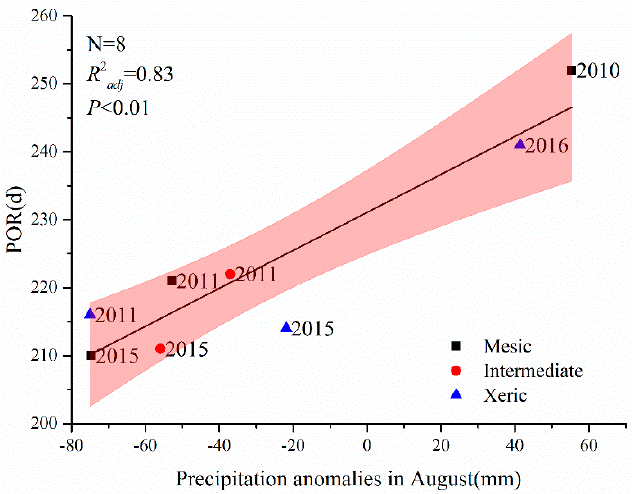
Figure A5. Impact of precipitation in August on POR (peak of recovery) after short-term summer drought by site. Pink shaded area represents 95% confidence interval.